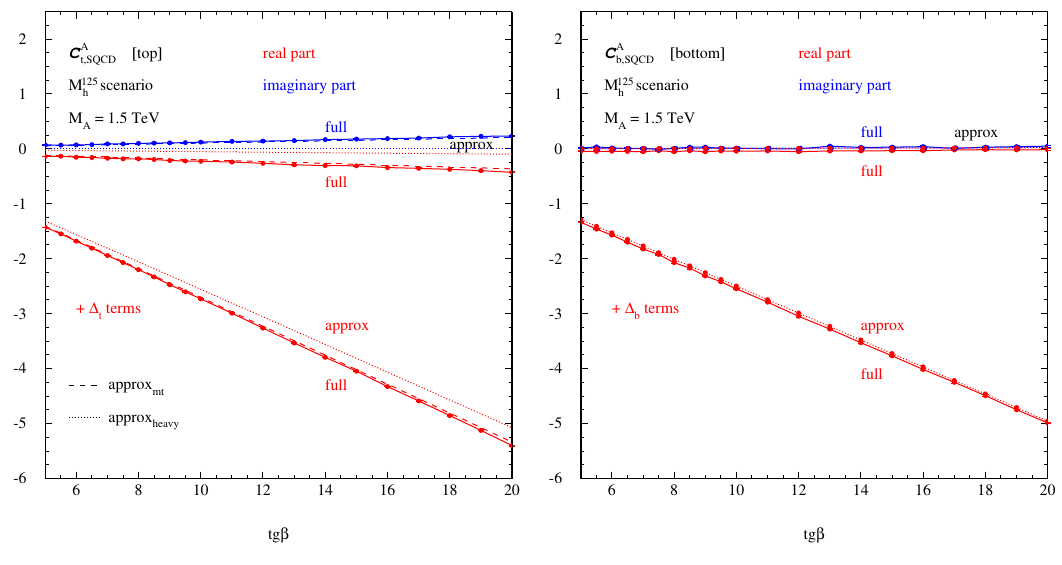
Figure 8 . The same as figure 6, but as a function of tg β for M A = 1 . 5